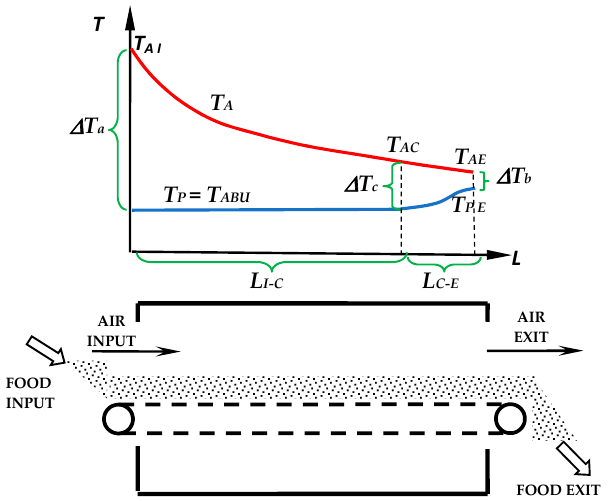
Figure 1. The conveyor-belt dryer with tangential flow and diagram of the temperature of the air and product with final moisture content X F lower than the critical one X C ( X F < X C ).